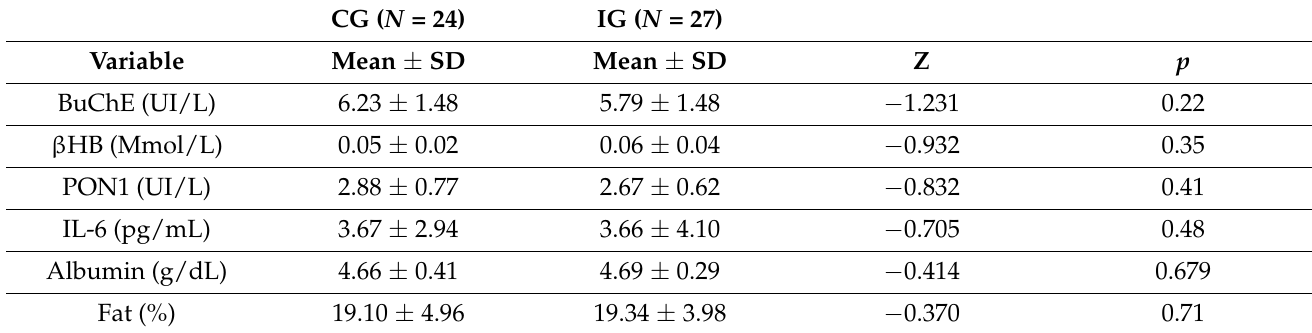
Table 2. Clinical characteristics of the population of the study before intervention